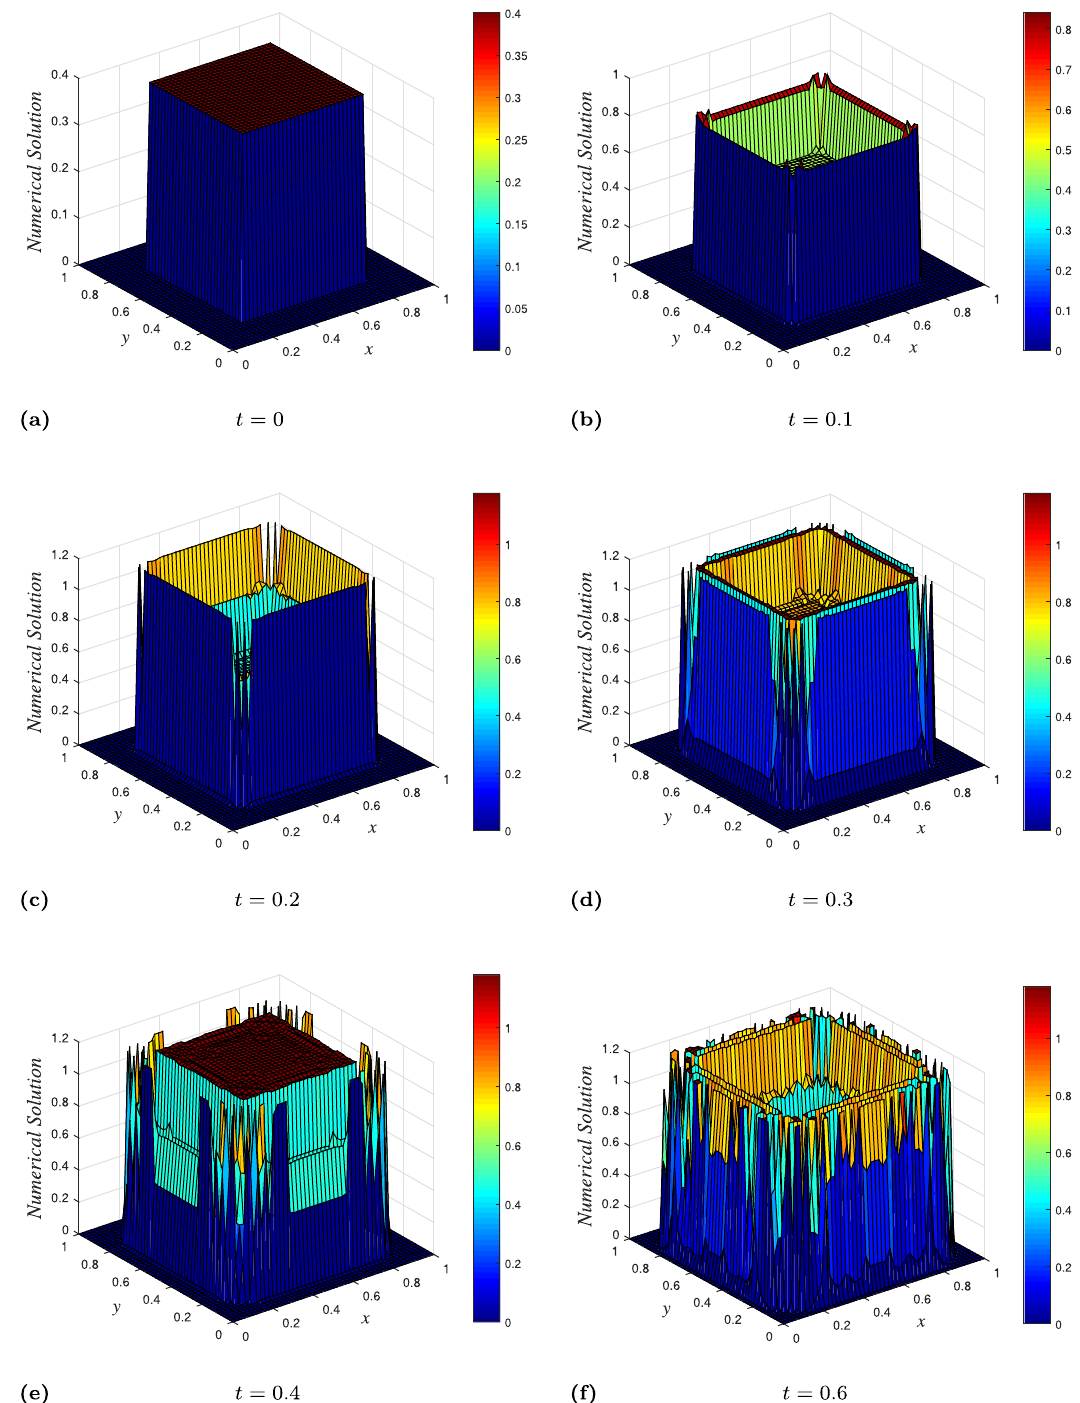
Figure 7: Plot of numerical solution vs x vs y using classical scheme at times = t 0, 0.1, 0.2, 0.3, 0.4 , and 0.6 with spatial step sizes = = h h 0.02 x y and time - step = k 0.0015 . ( a ) = t 0 . ( b ) = t 0.1 . ( c ) = t 0.2 . ( d ) = t 0.3 . ( e ) = t 0.4 . ( f ) = t 0.6